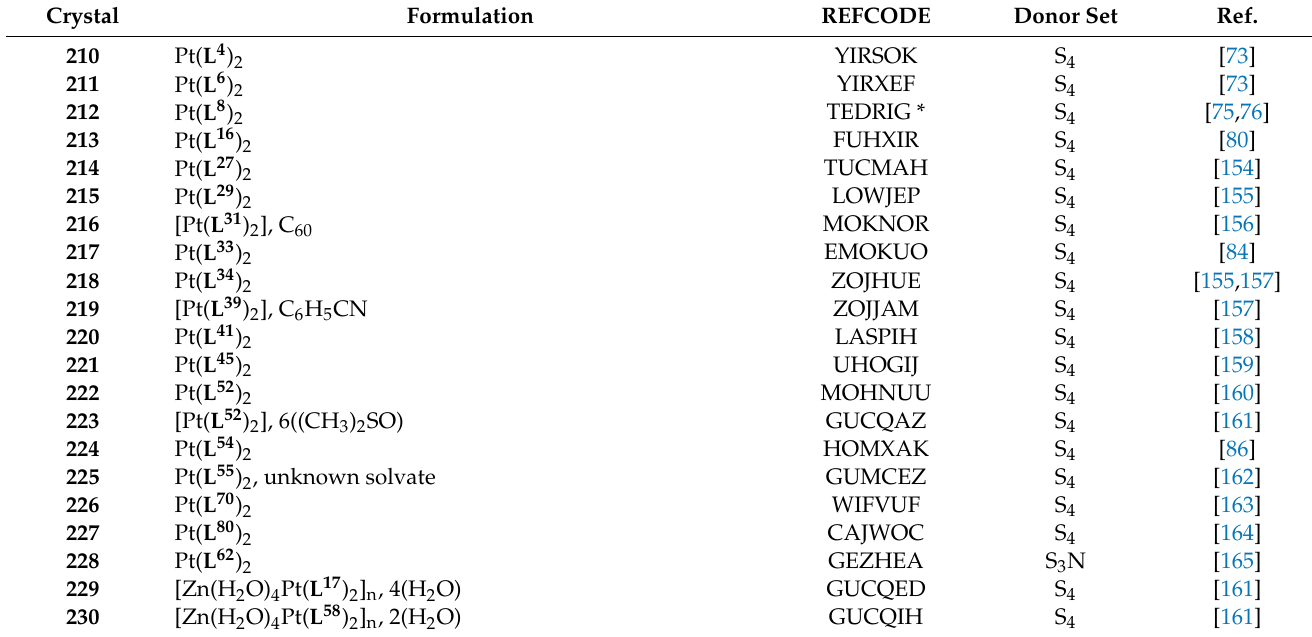
Table 7. Summary of platinum dithiocarbamate structures established by X-ray crystallography. See Table 1, Figure 2, and the Abbreviations